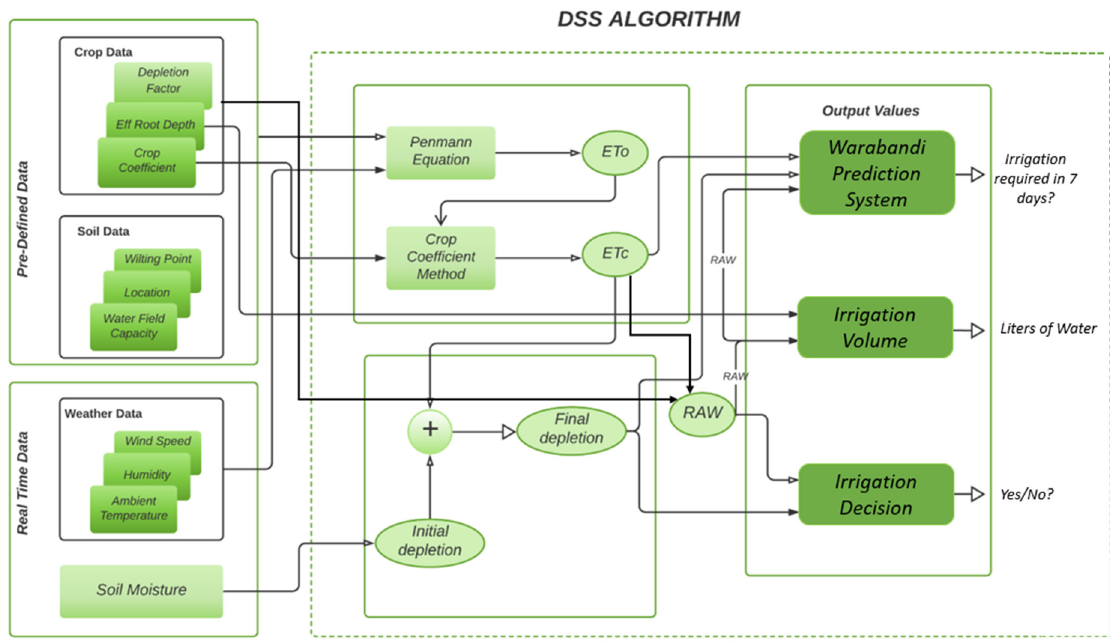
Figure 6. DSS algorithm.